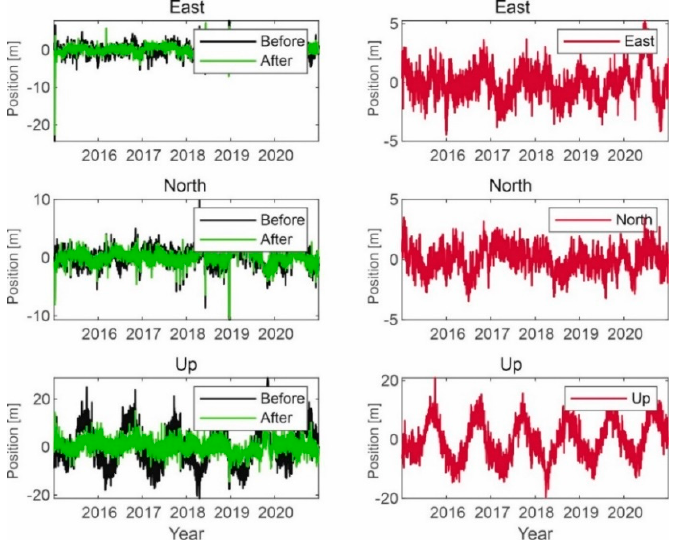
Figure 13. Signal processing in the Galileo receiver operating on the L1 frequency; on the left side, the signal waveform in color without the noise suppression system applied; on the right side, the working system operating in the LTE system signal elimination for the reception of signals from four satellites.